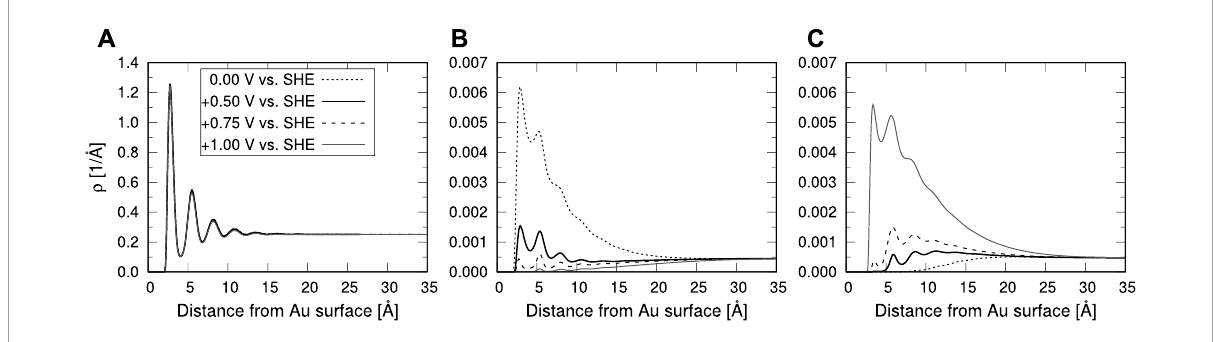
FIGURE 7 Density profiles as a function of distance from the Au(111) surface. Different panels show results for: (A) water molecules, (B) H 3 O + electrolyte ions and (C) Cl − electrolyte ions. Different lines represent the results computed with the ESM–RISM approach at different electrode potentials. The potential of zero charge (pzc) is located at 0.5 V vs. SHE.